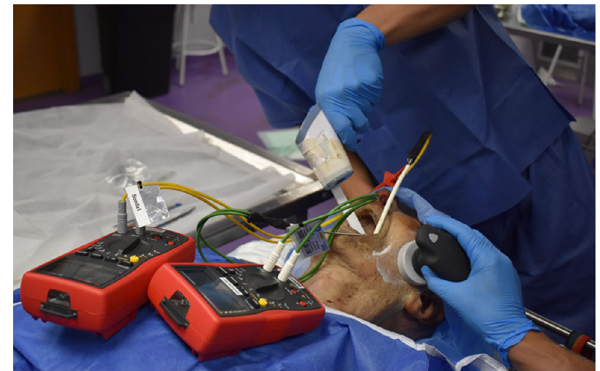
Figure 2. Example of application of CRet intervention (CAPH) in molars and placement of temperature